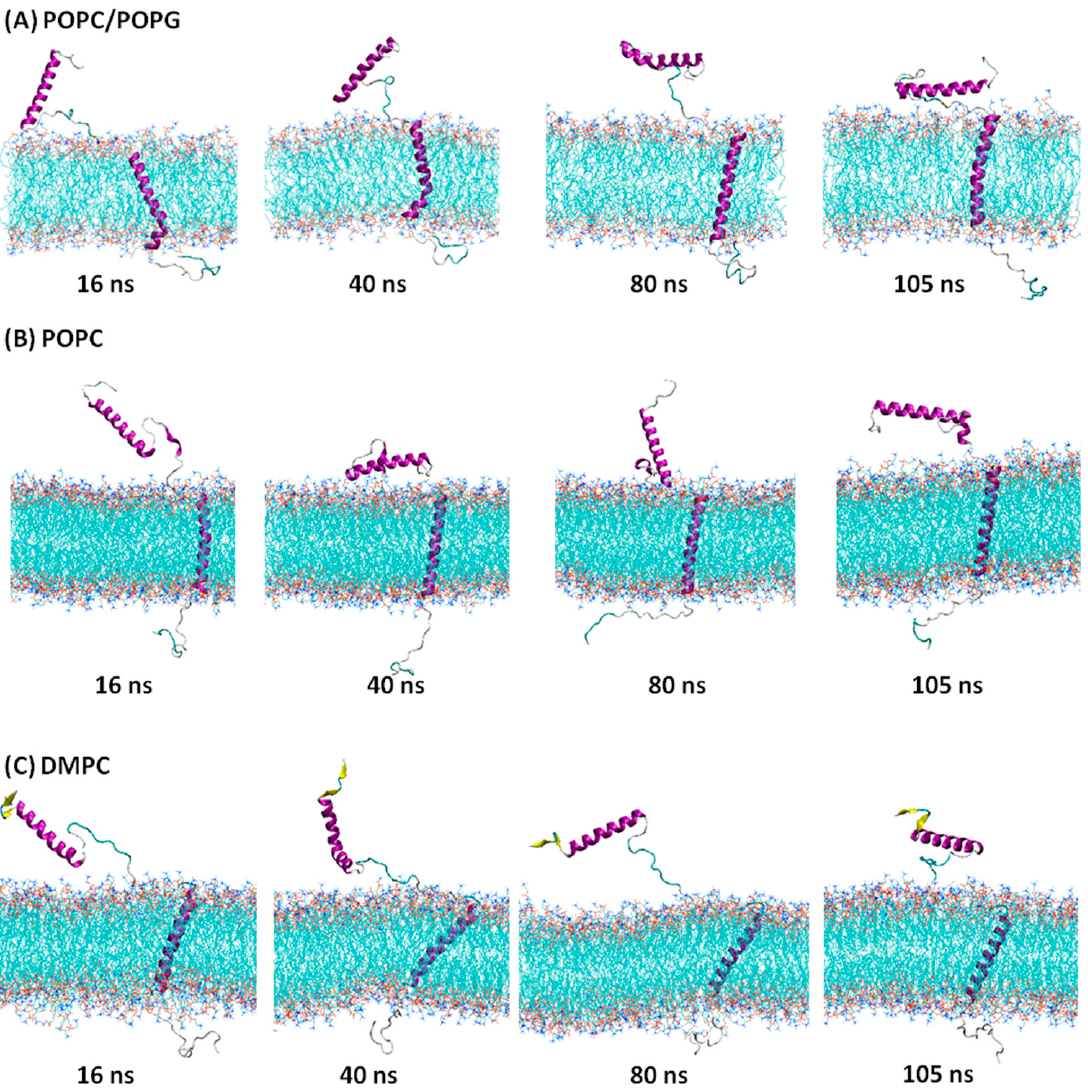
Figure 2. Snapshots of the representative MD simulation trajectory data of KCNE3 at 16 ns, 40 ns, 80 ns, and 105 ns for POPC/POPG ( A ), POPC alone ( B ), and DMPC alone ( C ) lipid bilayers. The hydrogen atom and water are omitted to make visualization simple and clear.